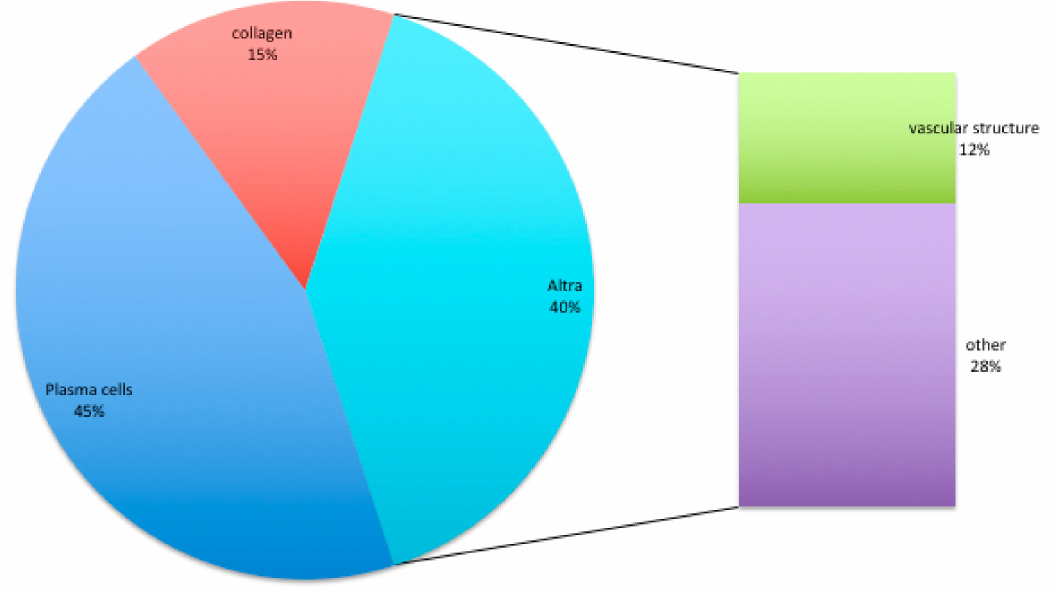
Figure 7. Composition of ICT tissue in % obtained by means of istomorphology. Collagen fibers in PI samples (Figure 8) were often free of cells (black arrows). In the central and apical portion of the ICT, collagen fibers were indeed deprived of fibroblasts while inflammatory cells dominated the lesion (Figure